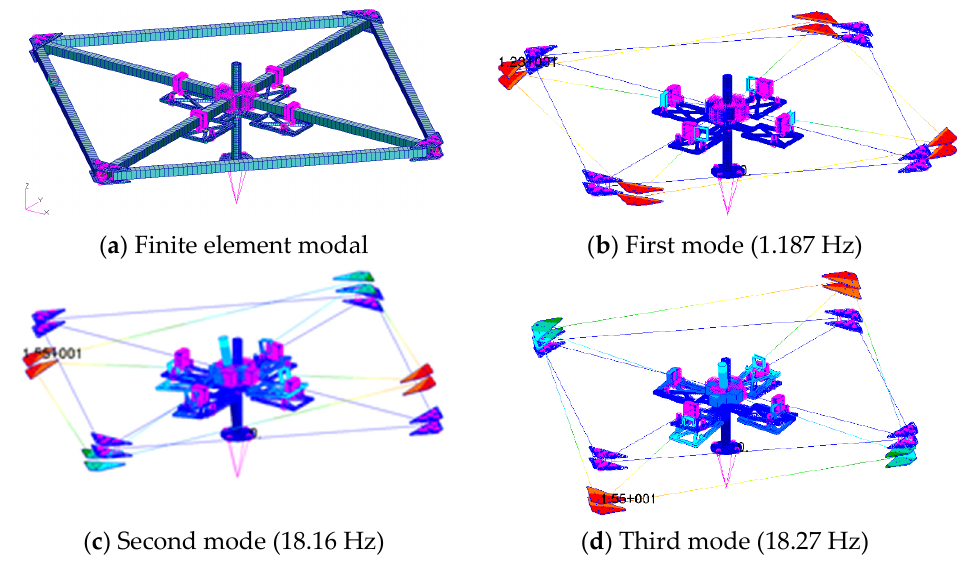
Figure 14. Finite element model and the first three modes of the SAS. Figure 14b–d show the first three modes of the SAS; the moment of inertia of the finite element model along the rotation axis was 8.46 kg·m 2 . On the other hand, the natural fre- quency and moment of inertia of the SAS were measured, as shown in Figure 15.